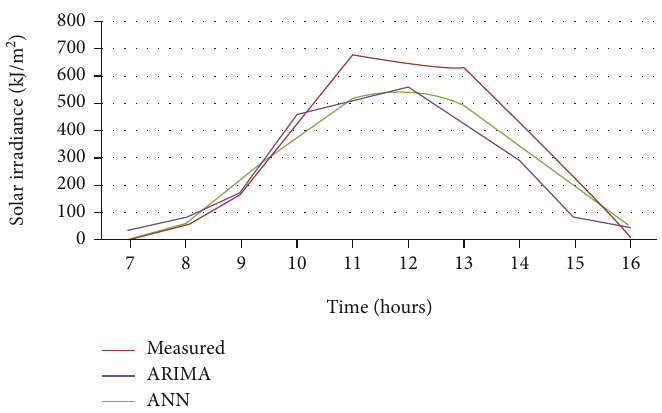
Figure 10: Solar radiation forecast for 20.01.2009 prepared with ARIMA and ANN